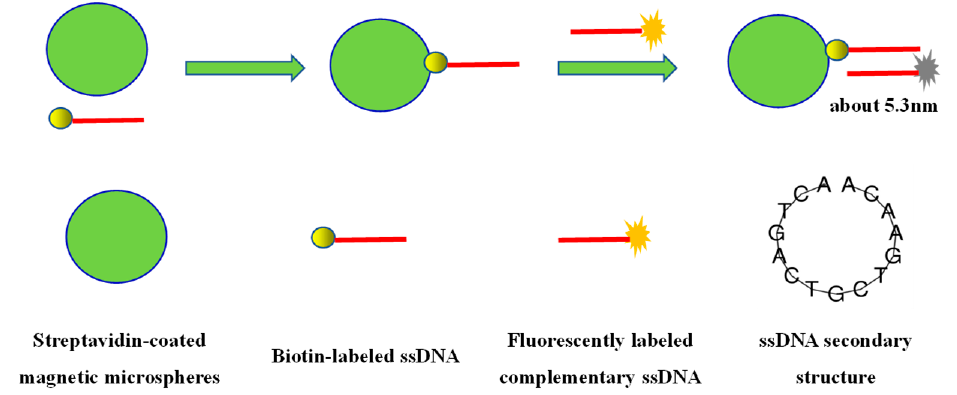
Figure 3. The research idea of fluorescence quenching effect between magnetic microspheres and fluorescent molecules. Figure 4a,b are the fluorescence emission scanning results of Alexa405 labeled ssDNA at excitation wavelengths of 300 nm and 370 nm, respectively.